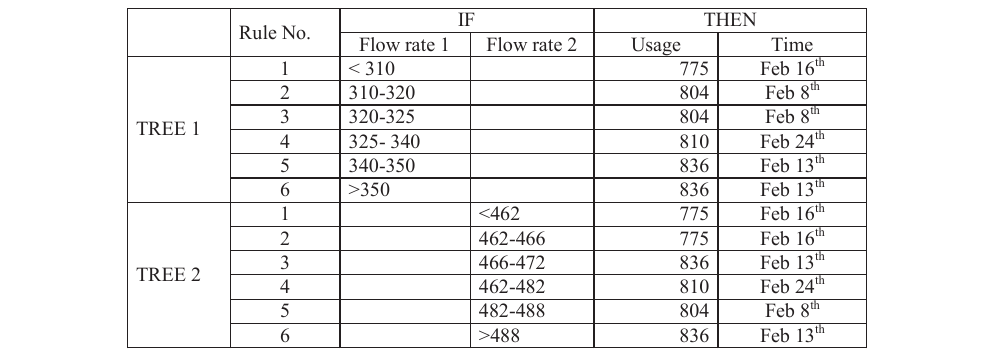
Table 5. Decision Rules for Stage 3